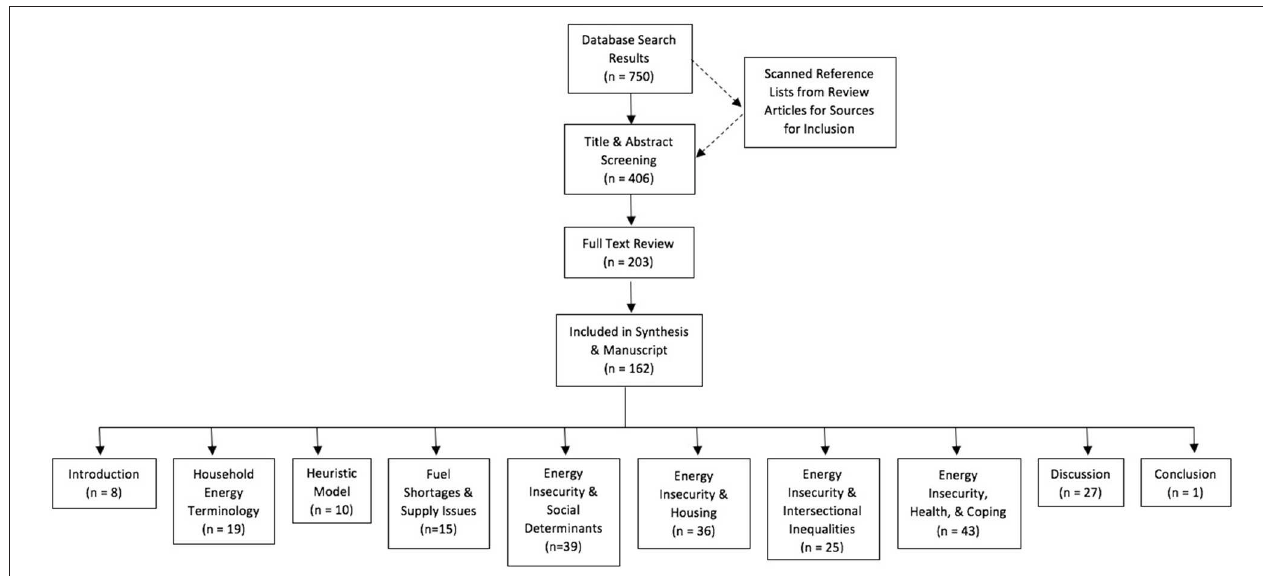
FIGURE 1 | Flow chart of literature selection and review process.